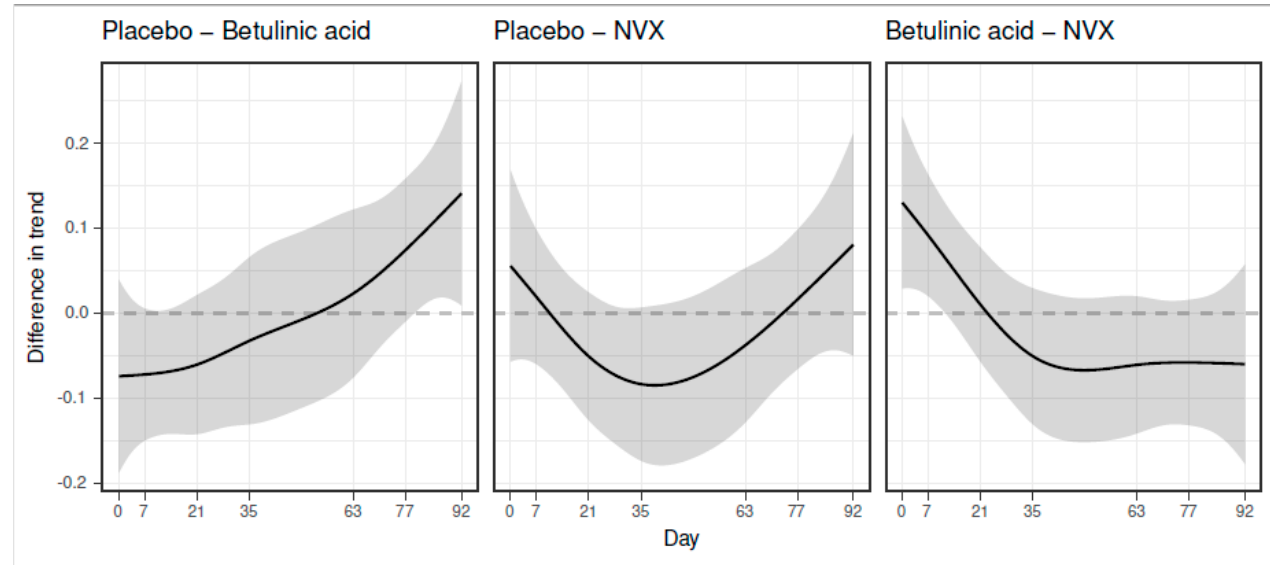
Figure 3. Pairwise differences between the smoothed curves of the different groups. Differences were formed from the predicted mean curves of tumor volumes and confidence intervals to visualize the time:group interaction. The difference between the groups named on top of the plots is significant when the dotted zero line lies outside of the confidence interval (in gray). For example, in the first half of the study period, the mean tumor volume in the BA group was larger than the mean tumor volume in the placebo group (resulting in negative values when the difference was formed). Thereafter, the volumes of tumors treated with BA were smaller than the volumes of tumors in the placebo group (resulting in positive values when the difference was formed). This difference was significant towards the end of the treatment period (zero line is outside the confidence interval from day 80). The difference between smooths is on the link scale and thus does not correspond to a difference in absolute tumor volume.